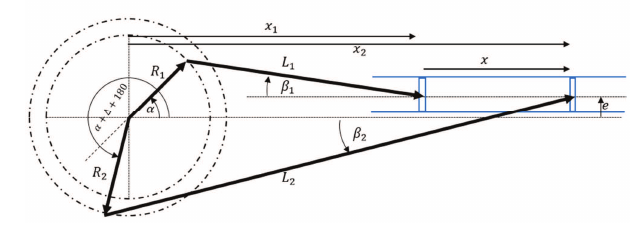
Fig. 5. SSPOP engine scheme